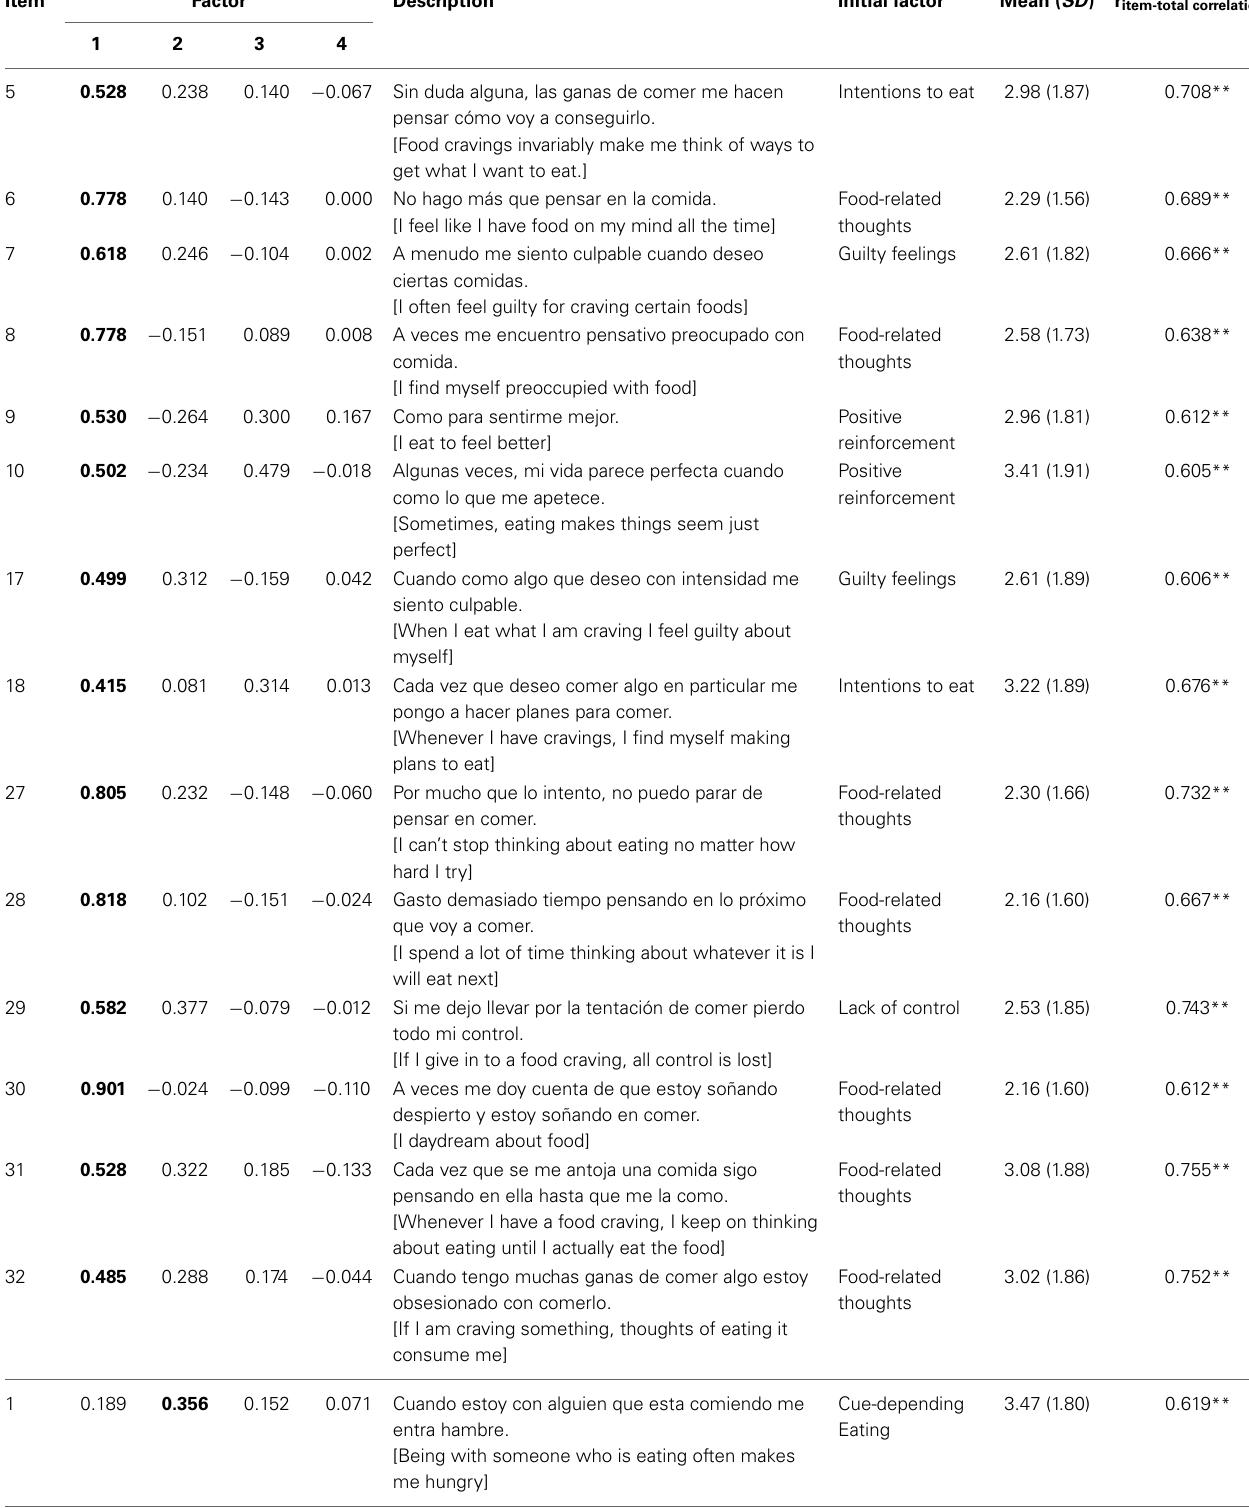
Table 2 | Factor loadings and item statistics of the food craving questionnaire trait. Item Factor Description Initial factor Mean ( SD ) r item-total